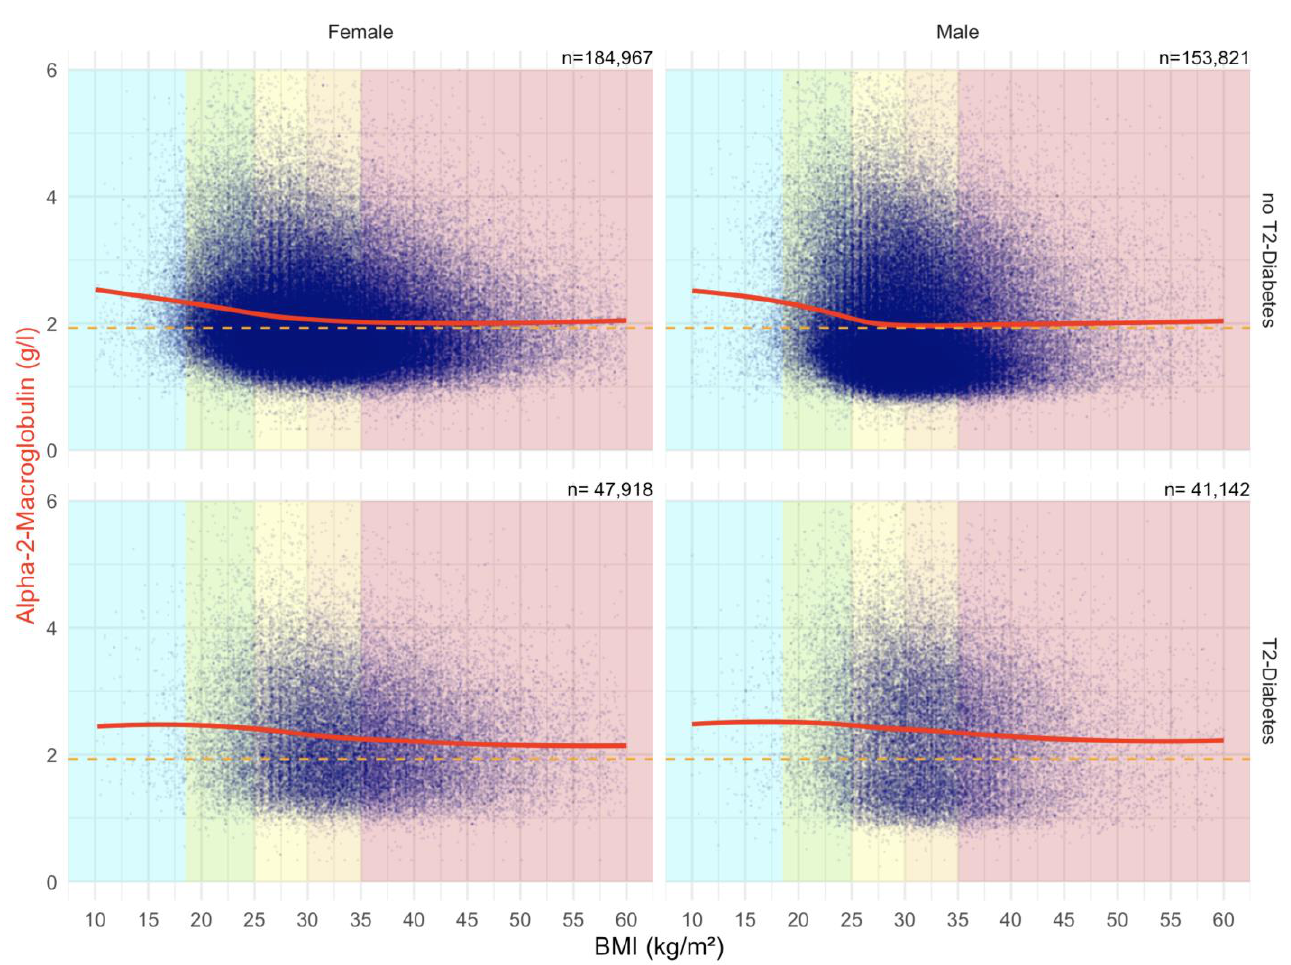
Figure 8. Impact of BMI on the A2M concentrations in “ NAFD – Serum ” cohort. Median value is the horizontal orange – dashed line. Five vertical zones mark the 5 BMI groups (WHO definition cut-offs: 18.5, 25, 30, 35 and above 40 kg/m 2 ). Each blue point is a protein patient value with its BMI. The red curve is a Loess regression of the median of A2M values. Impact of BMI on ApoA1 Serum Level in the “NAFLD-Serum” Cohort In all patients, there was a negative correlation between ApoA1 and BMI (Figure 9).